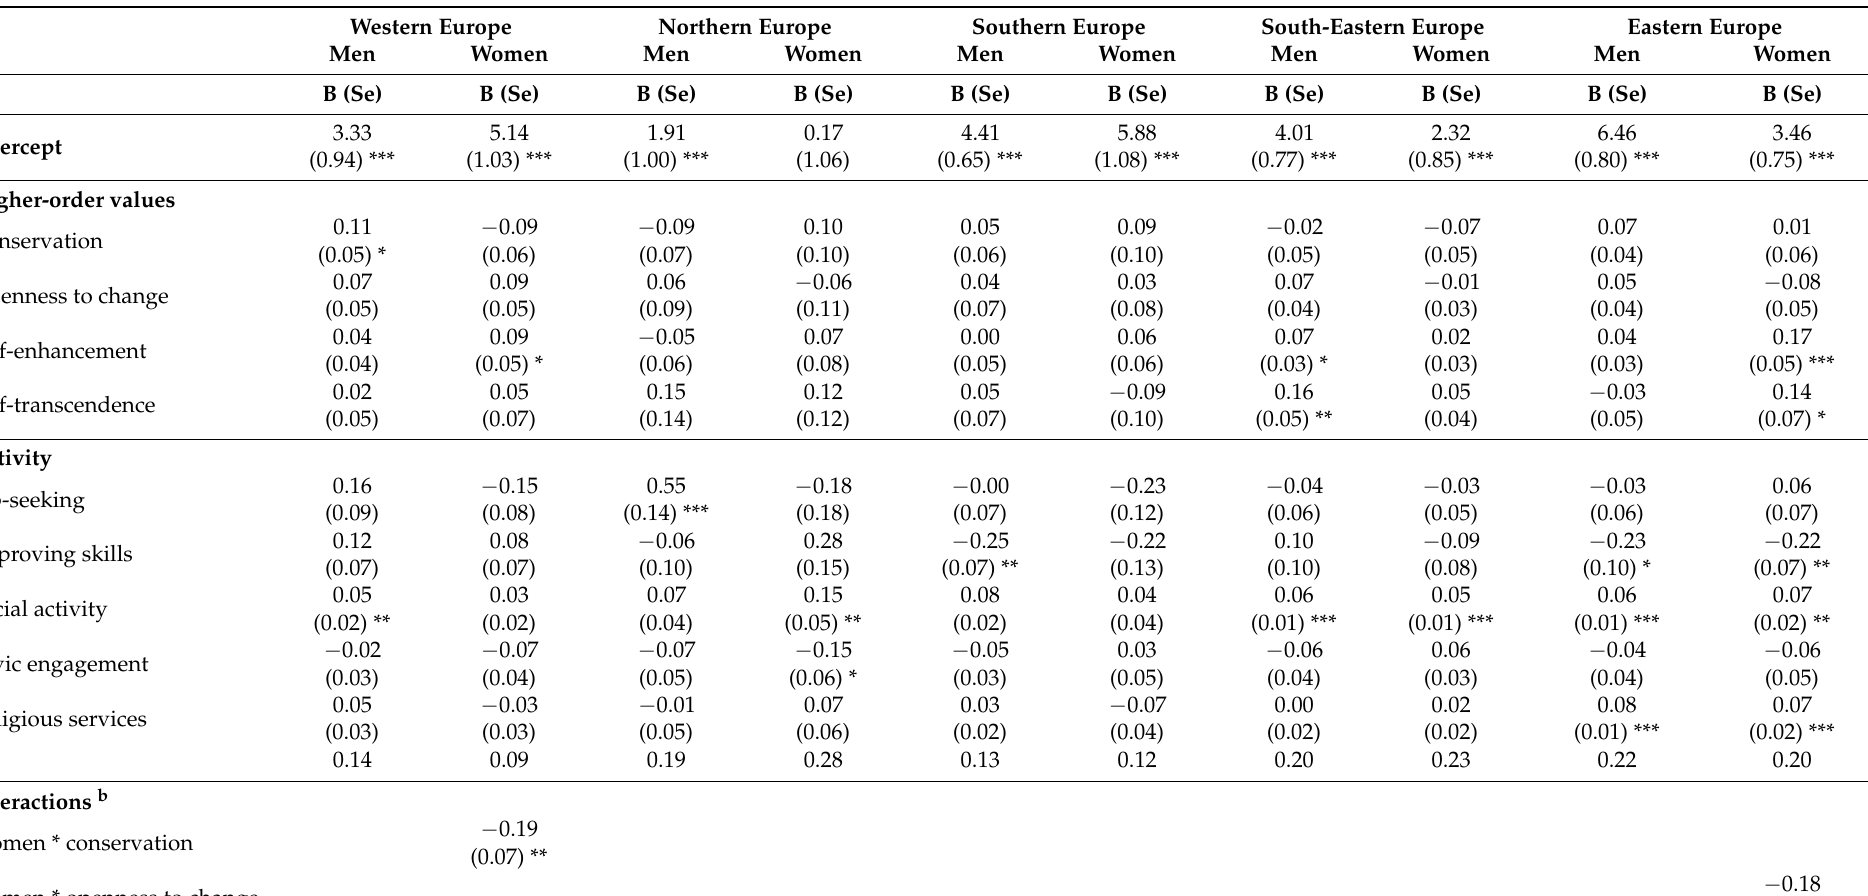
Table 3. Unstandardised betas (standard errors) for the association between SRH and values in NEET young men and women stratified by European region a